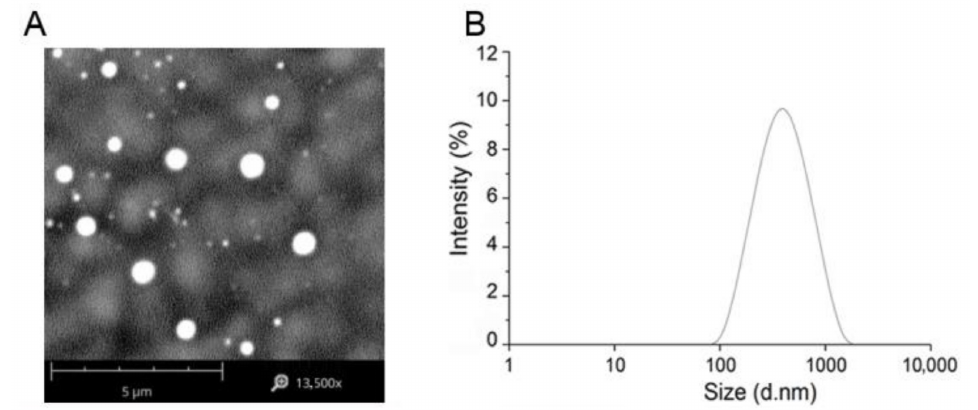
Figure 3. Morphology and particle size distribution of NP-OmpA. ( A ), scanning electron micro- graph of NP-OmpA; ( B ), particle size distribution of NP-OmpA. The surface morphology and size distribution of NP-OmpA were uniform and spherical, and the particle size was about 700 nm.